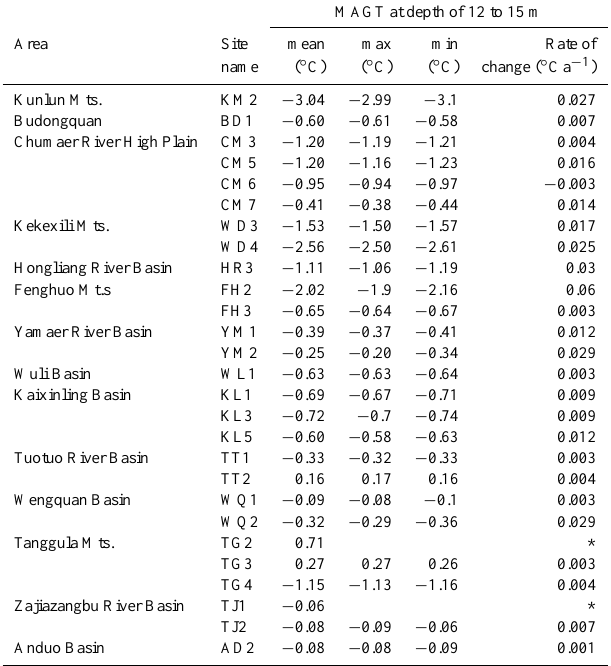
Table 4. Multi-year mean, maximum, minimum, and changing rate of mean annual ground temperature from 2006–2010.